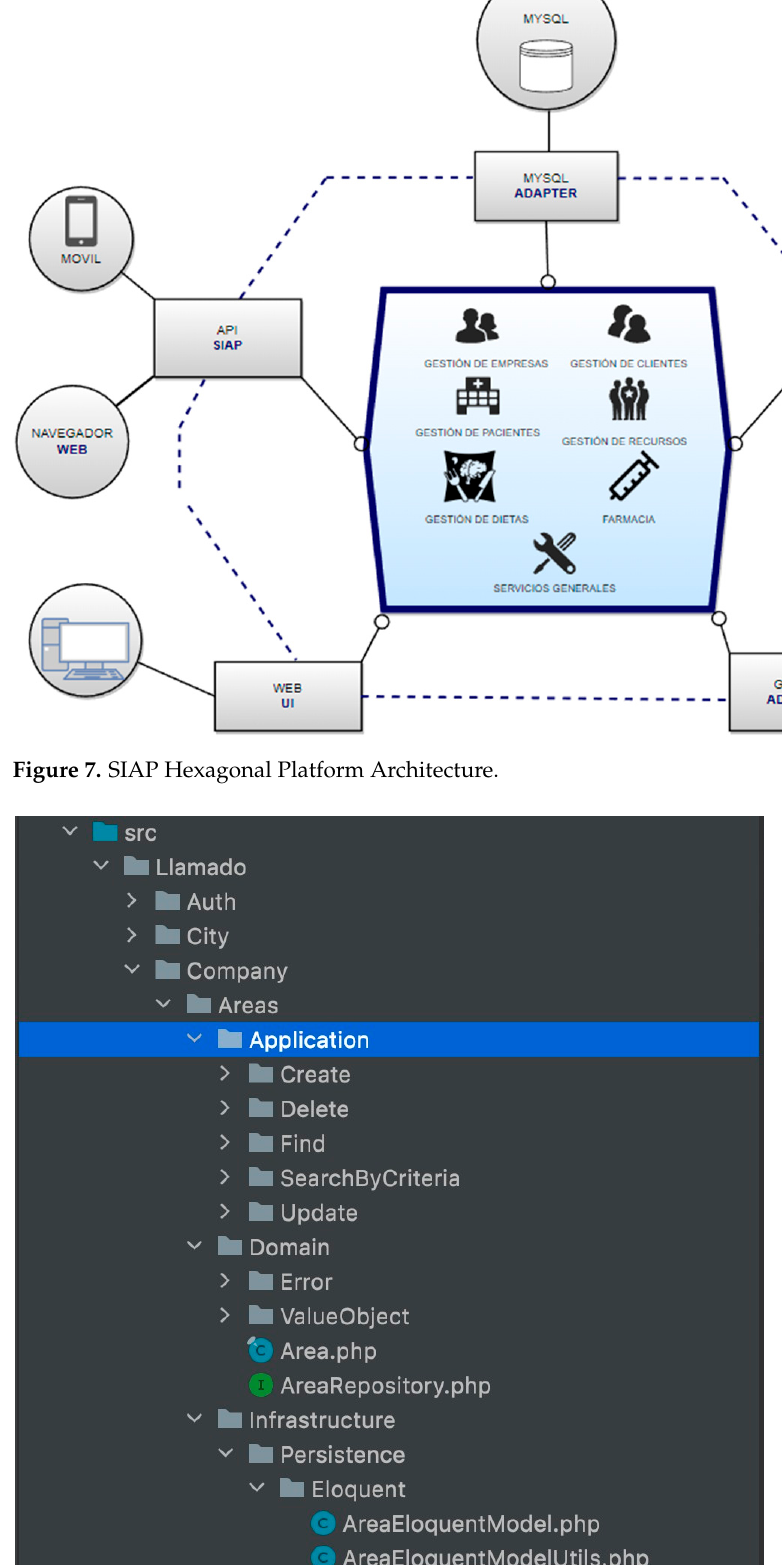
Figure 8. Project Structure.